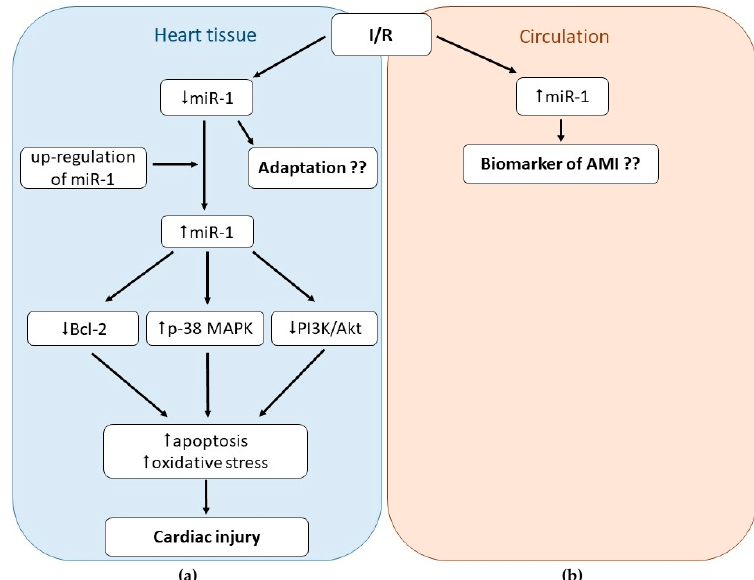
Figure 2. Role of microRNA-1 (miR-1) in cardiac ischemia-reperfusion (I/R) injury. MiR-1 seems to play diverse roles in I/R injury. In the heart tissue, miR-1 is down-regulated due to I/R ( a ) but up-regulated in circulation ( b ), thus suggesting miR-1 as a potential biomarker of I/R injury. Up-regulation of miR-1 in the heart tissue (e.g., in transgenic animals or older patients) seems to exacerbate I/R injury via promoting oxidative stress and apoptosis (a).